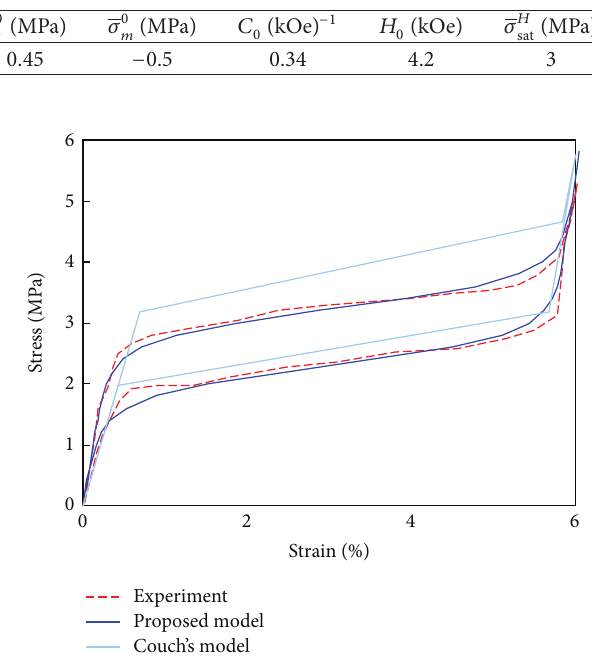
Figure 4: Comparison of Couch’s quasi-static model and proposed model. The corresponding experiment is carried out at an 8kOe external magnetic